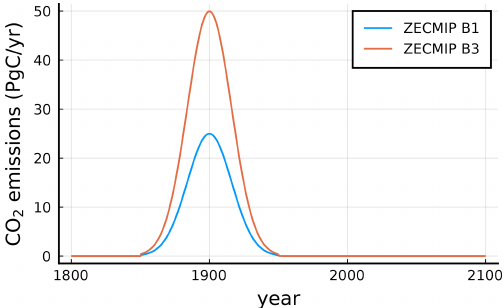
Figure 8. CO 2 emission curves for ZECMIP experiments B1 and